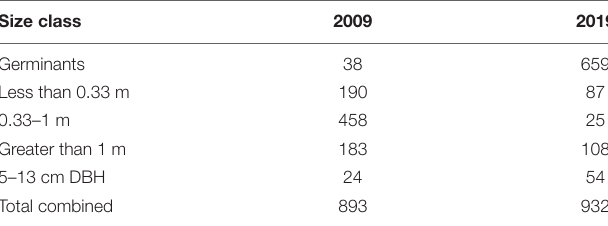
TABLE 2 | Mean trees per hectare in 2009 and 2019 for total combined regeneration size classes across all